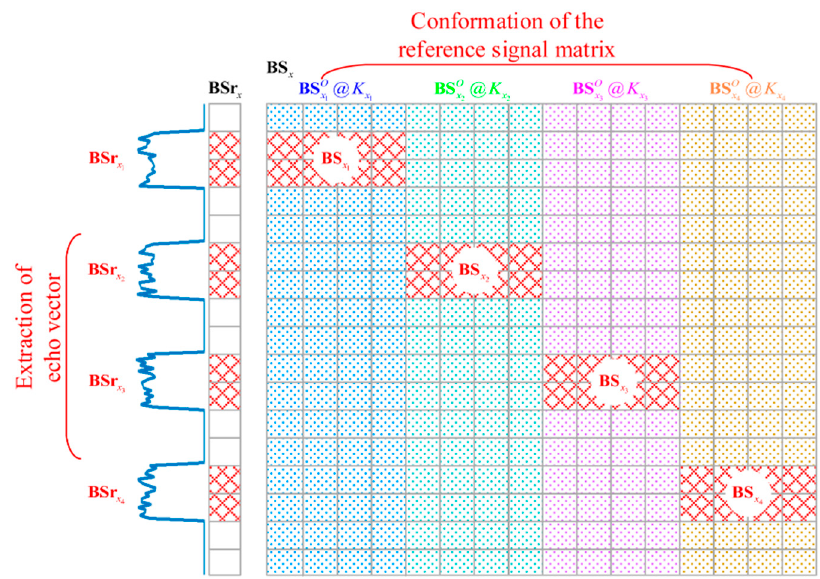
Figure 4. Extraction of the EV and conformation of the RSM for BP ‐ TCAI.